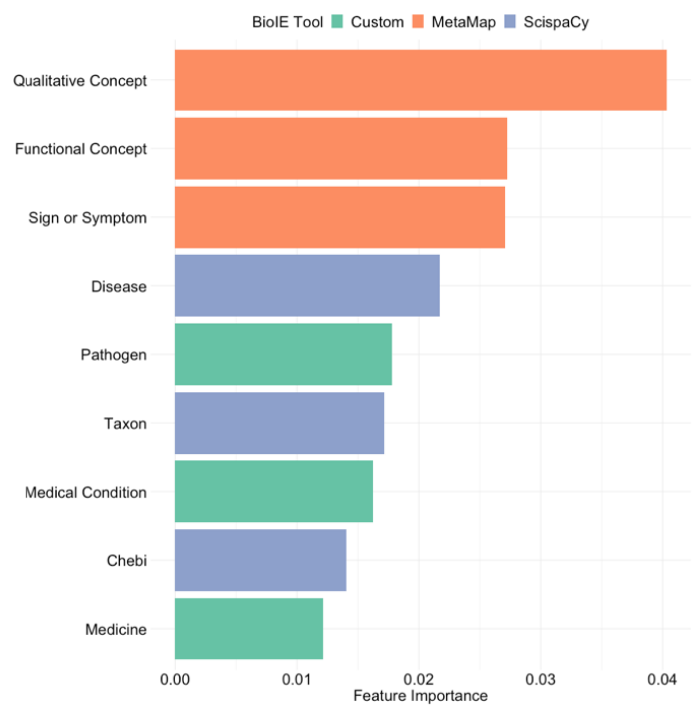
Figure 4. Top 3 important features for 3 biomedical information extraction tools .